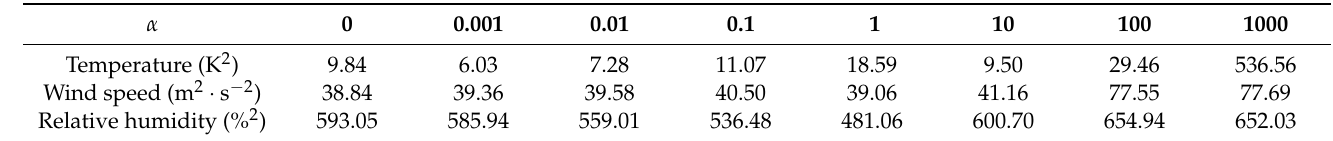
Table 2. cv-MSE cross-validation results with grid search for parameter α in the regularized neu- ral